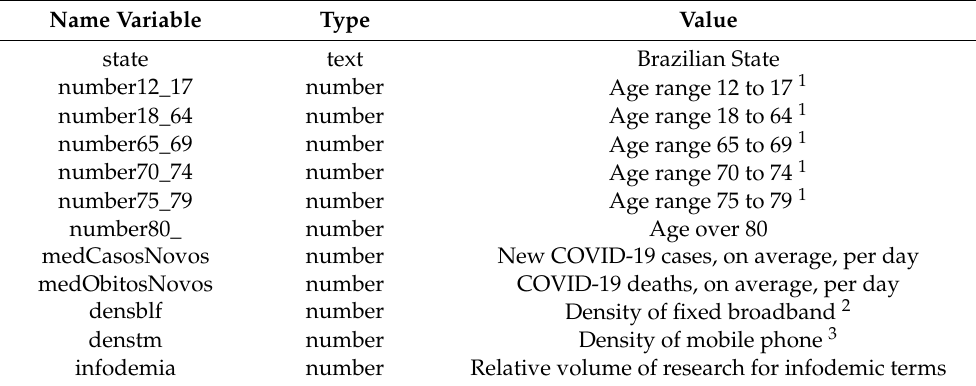
Table 1. Description of the variables selected in the